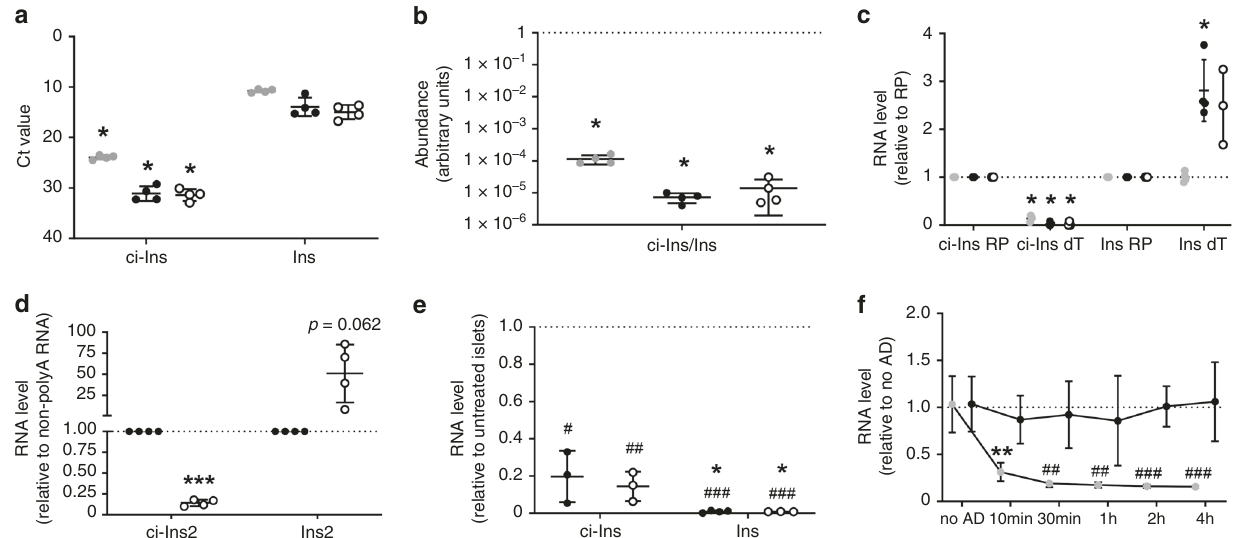
Fig. 2 ci-Ins2 is a stable circular intronic RNA. a – c Mouse (gray circles) and rat (black circles) ci-Ins2 and Ins2 , and human (clear circles) ci-INS and INS were analyzed in islet RNA samples by qPCR. The expression of the circRNAs was assessed using over-junction primers. a Ct values in 10 ng RNA, b relative circRNA/mRNA abundance (log 10 scale), and c RNA levels in oligo dT (dT) cDNA relative to random primer (RP) cDNA measured by qPCR. n = 3 ( c , human) and 4 ( a – c (mouse and rat)) independent experiments. * p ≤ 0.001 ( a – c (ci-Ins dT) and * p = 0.011 ( c , rat Ins2 dT) vs. Ins2 , INS , or RP by two- tailed unpaired or one-sample t -test. d Rat ci-Ins2 and Ins2 measured by qPCR in islet polyA RNA (clear circles) relative to non-polyA RNA (black circles). n = 4 independent experiments. *** p = 0.000025 vs. non-polyA RNA by two-tailed one-sample t -test. e Rat ci-Ins2 and Ins2 (black circles) and human ci- INS and INS (clear circles) measured by qPCR in RNase R-treated islet RNA relative to untreated RNA. n = 3 and 4 (rat Ins2 ) independent experiments. # p = 0.01, ## p = 0.003, and ### p < 0.0001 vs. no RNase R-treated RNA and * p = 0.04 vs. ci-Ins2 or ci-INS by two-tailed one-sample or unpaired t -test. f ci-Ins2 (black circles) and Ins2 intron 1 (gray circles) normalized to Hprt1 , measured by qPCR, in rat islet cells after actinomycin D treatment relative to no treatment (no AD). n = 5 independent experiments denoted as the mean. ** p = 0.008 vs. no AD Ins2 intron 1, ## p = 0.003 (30 min), ## p = 0.008 (1 h), ### p = 0.0003 (2 h), and ### p = 0.0001 (4 h) vs. ci-Ins2 at the corresponding time point by two-way ANOVA and Tukey post hoc test. a – f Data and mean are represented ± s.d. Source data are provided as a Source Data fi le.